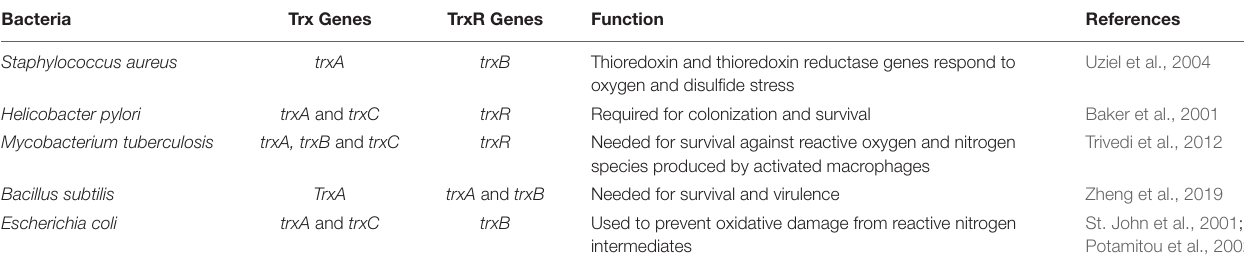
TABLE 1 | Bacterial TS genes and their respective